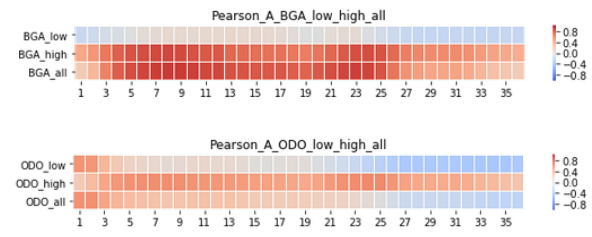
Figure 6. Band correlations for the parameters BGA and ODO, basins separately and the whole data